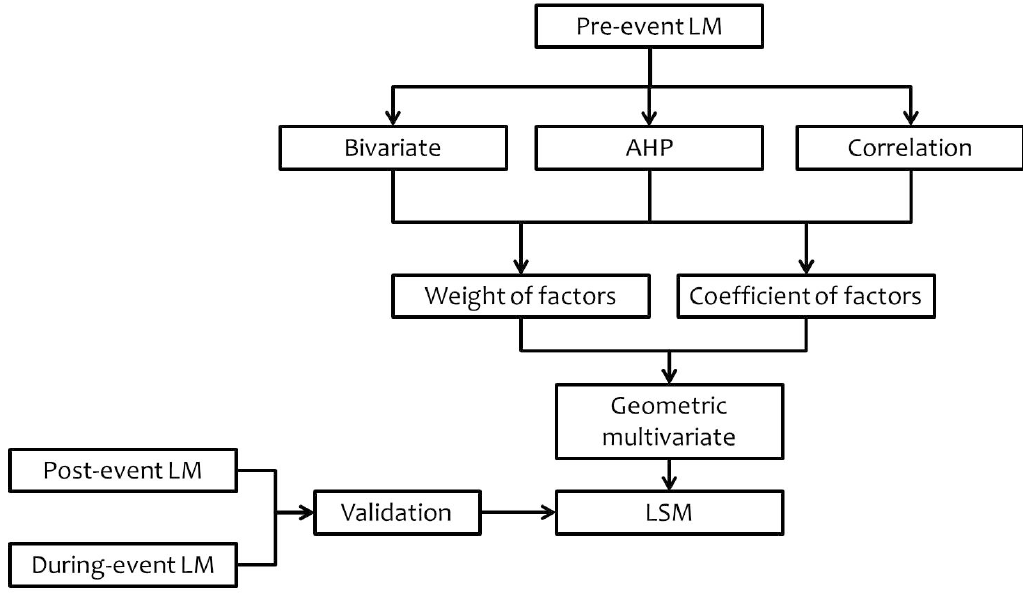
Figure 2. A flowchart of the research.